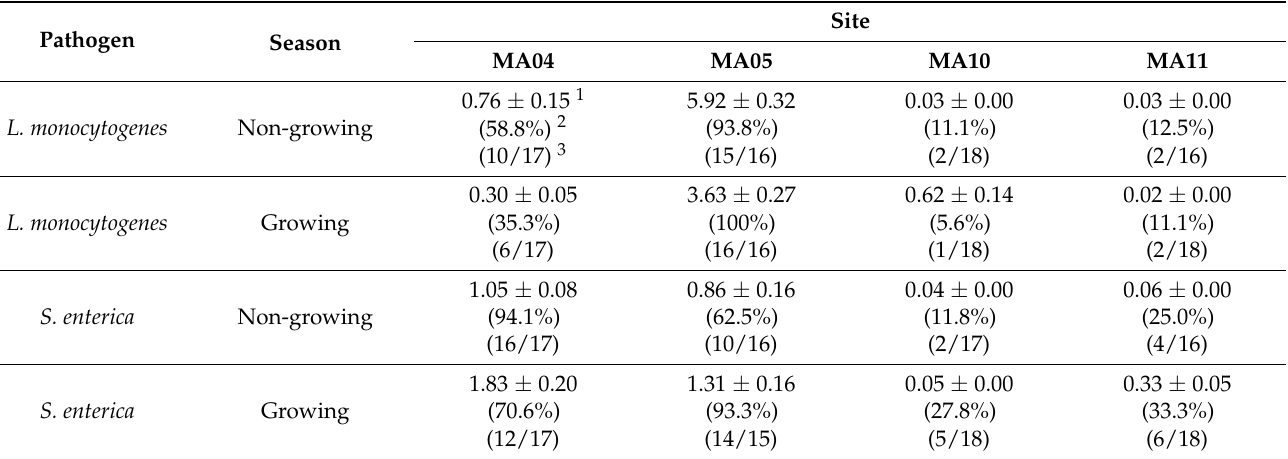
Table 1. Mean levels (MPN/L) of L. monocytogenes and S. enterica , followed by prevalence (percentage and number of samples which were positive for the pathogen) in non-growing (October–April) and produce-growing (May–September) seasons.